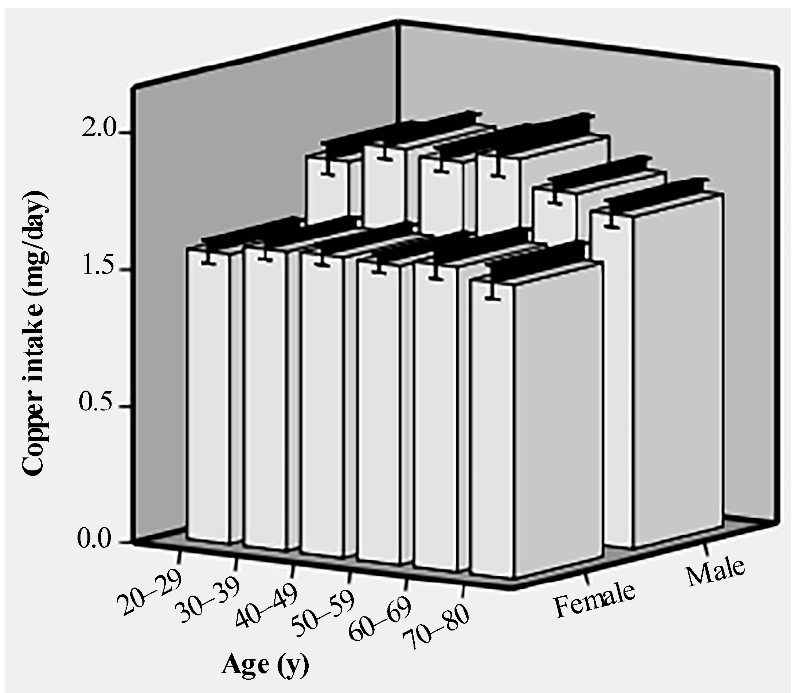
Figure 1. The dietary copper intake of males and females in different age groups before matching. As shown in Table 2, there were 399 cases of stroke. All covariates were associated with stroke ( p < 0.05), except for sex and HDL. The multivariate analysis (Figure 2) showed that the risk of stroke would increase by 1.05 times as the age increases by one year, p < 0.001. Subjects in non-Hispanic white, non-Hispanic black, and other race groups had a 1.68-, 1.89-, and 1.72-times higher risk of stroke than the Mexican American group, respectively, p < 0.05. The probability of stroke in subjects without hypertension was 0.48 times that of subjects with hypertension, p < 0.001. No history of asthma (OR = 0.63, p < 0.001), diabetes (OR = 0.65, p < 0.001), and trouble sleeping (OR = 0.79, p = 0.038) were all protective factors for stroke. However, fair/poor general health (OR = 4.09, p < 0.001) and epilepsy (OR = 5.59, p < 0.001) were risk factors for stroke. Most interestingly, the stroke risks of quartiles 2, 3, and 4 of dietary copper intake were 0.7 ( p = 0.01), 0.64 ( p = 0.003) and 0.6 ( p = 0.002) times that of quartile 1, respectively. Table 2. Characteristics of full and propensity score–matched cohorts by stroke. Before